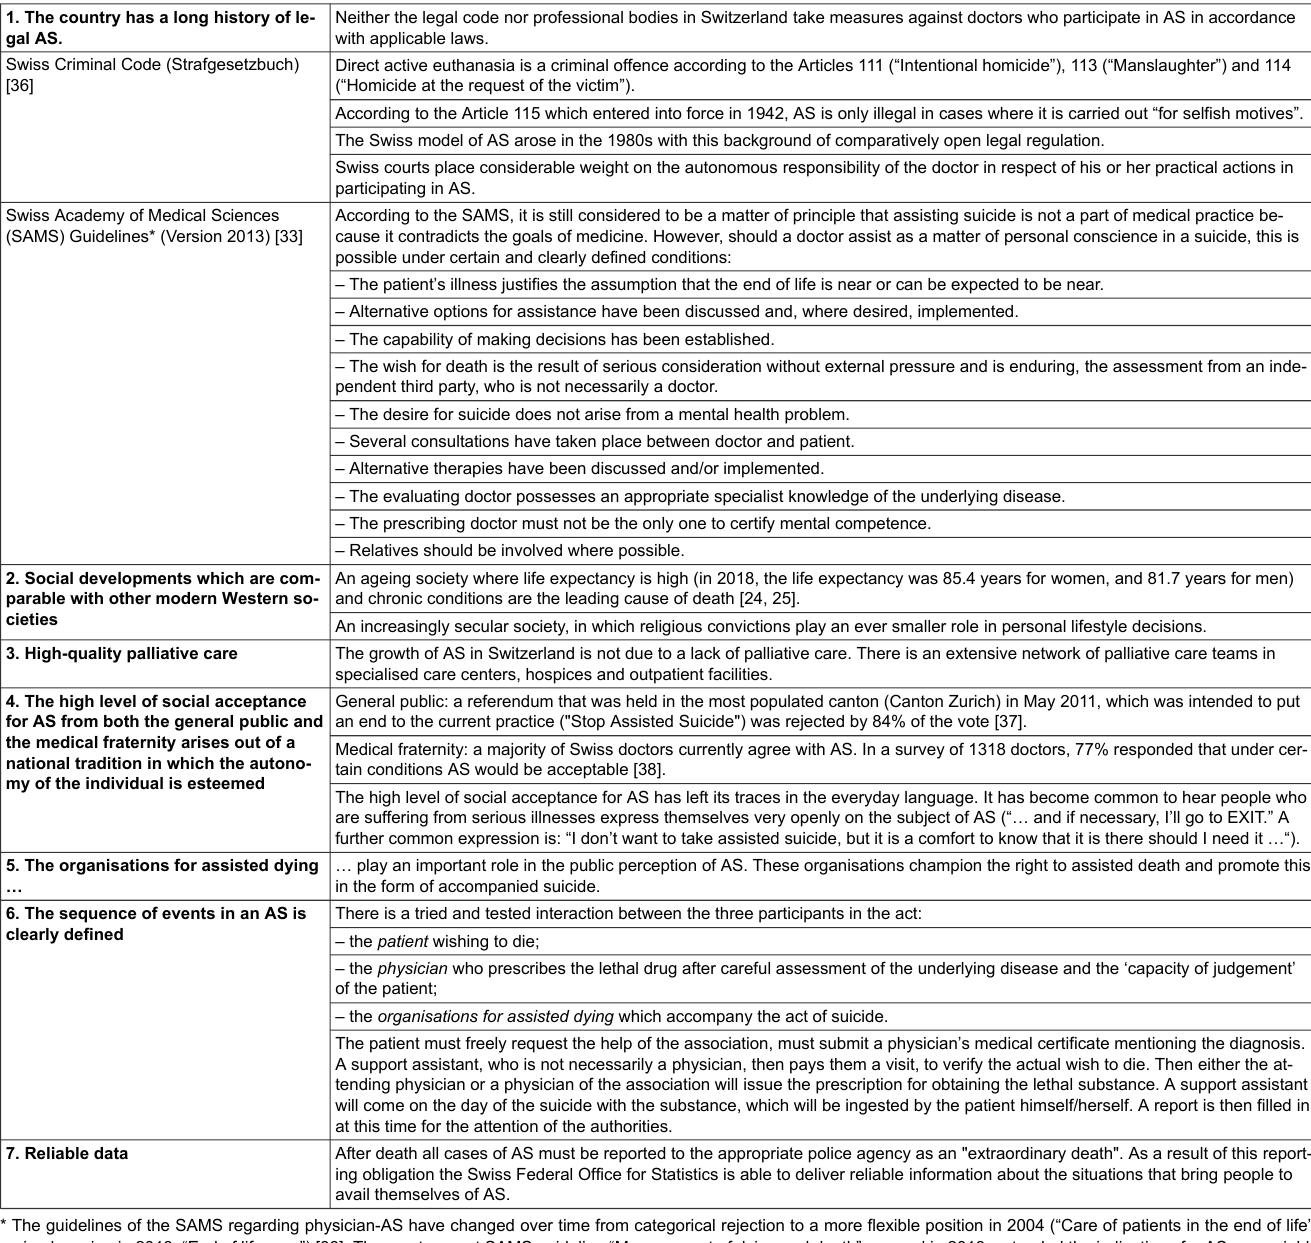
Table 1: The Swiss model of assisted suicide (AS): distinctive legal and social aspects [14, 15, 28]. 1. The country has a long history of le- gal